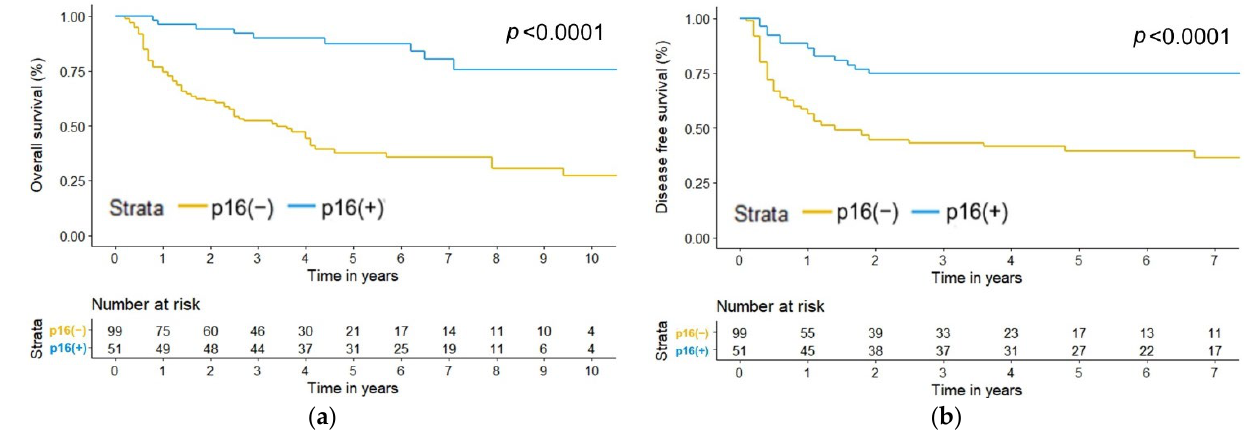
Figure 1. Kaplan–Meier estimate of ( a ) overall survival ( p < 0.0001) and ( b ) disease-free survival ( p < 0.0001) by p16 status.